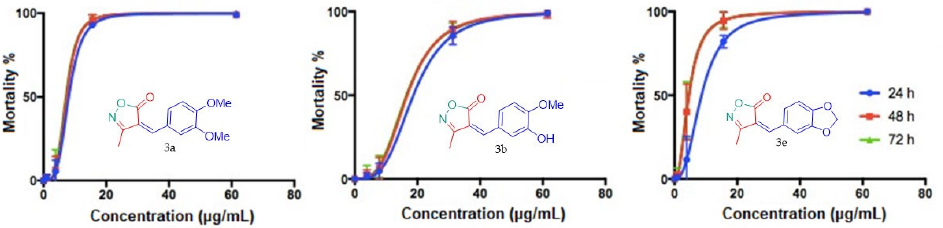
Figure 2. Larval mortality profile for the 3-methyl-4-arylmethylene isoxazol-5(4H)-one derivatives based on the WHO guidelines. Table 4. LC 50 ( μ g/mL) data for compounds 3a–g .